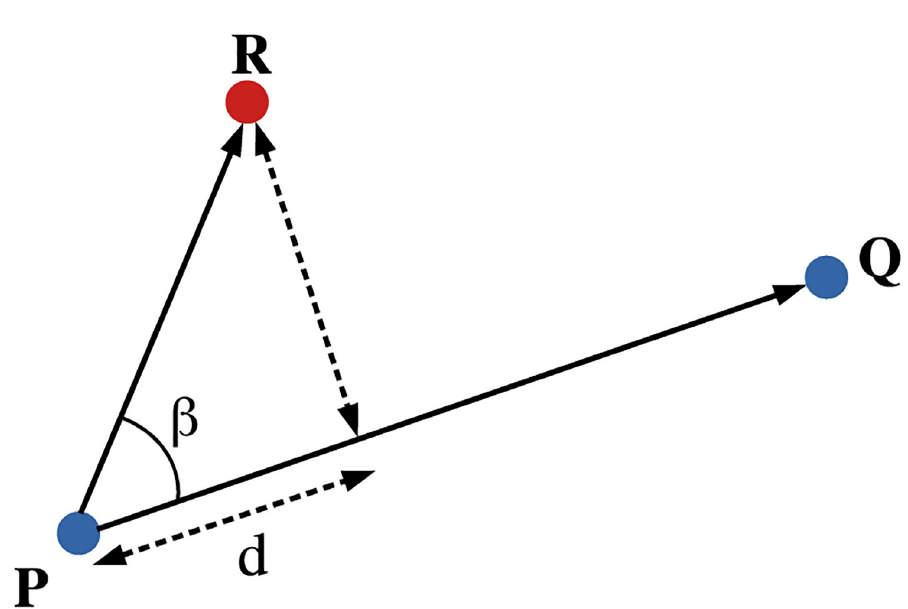
Fig 17. Schematic representation of the edge-cutting algorithm. The ‘edge’ between the pedestrians P and Q belonging to the same group is cut by the pedestrian R belonging to the other group.